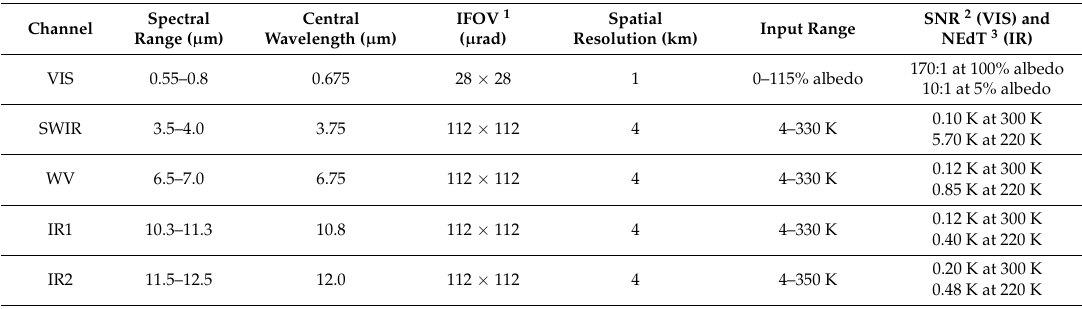
Table 1. Characteristics of COMS meteorological